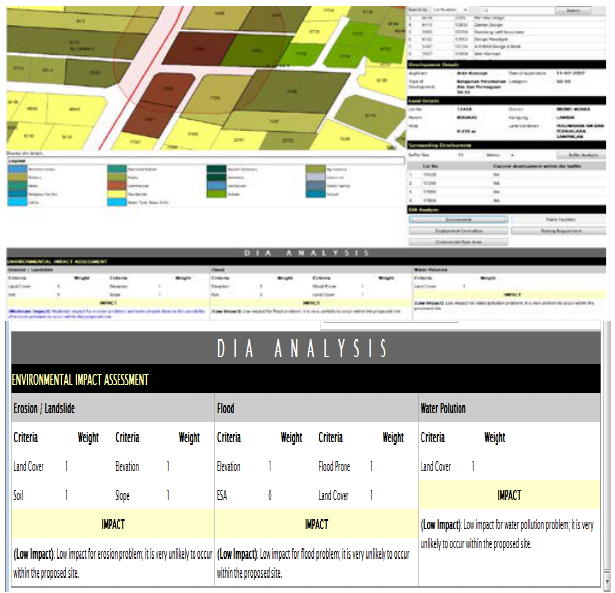
Figure 6: The e-DIA result display page showing the results of environment analysis